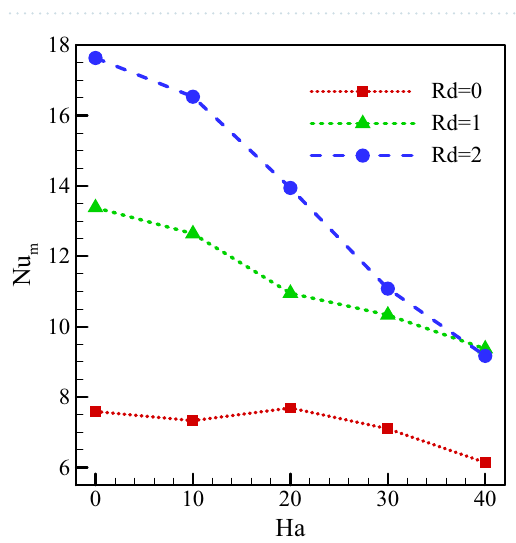
Figure 11. Variations of dimensionless ( a ) velocity and ( b ) temperature on line X = 0.5 for Ra = 10 5 , ω = 0, ϕ = 0.03, γ = 45 ◦ and various radiation parameters.